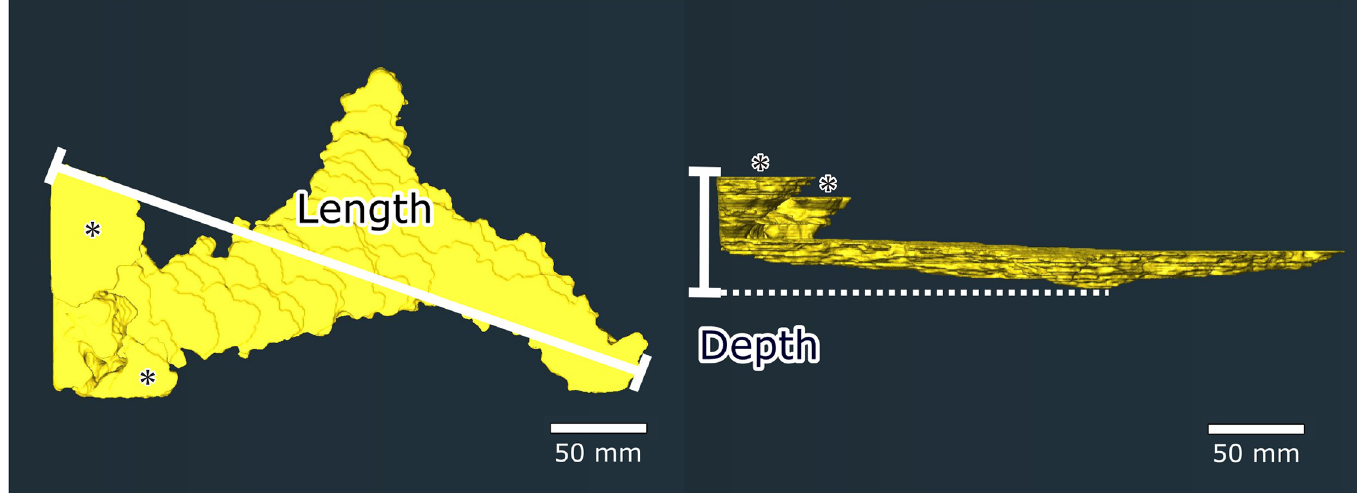
Fig 4. Measurements of burrow length and depth from computed tomography images. The left-hand and right-hand panels show top and side views, respectively. The asterisks show the burrow apertures.